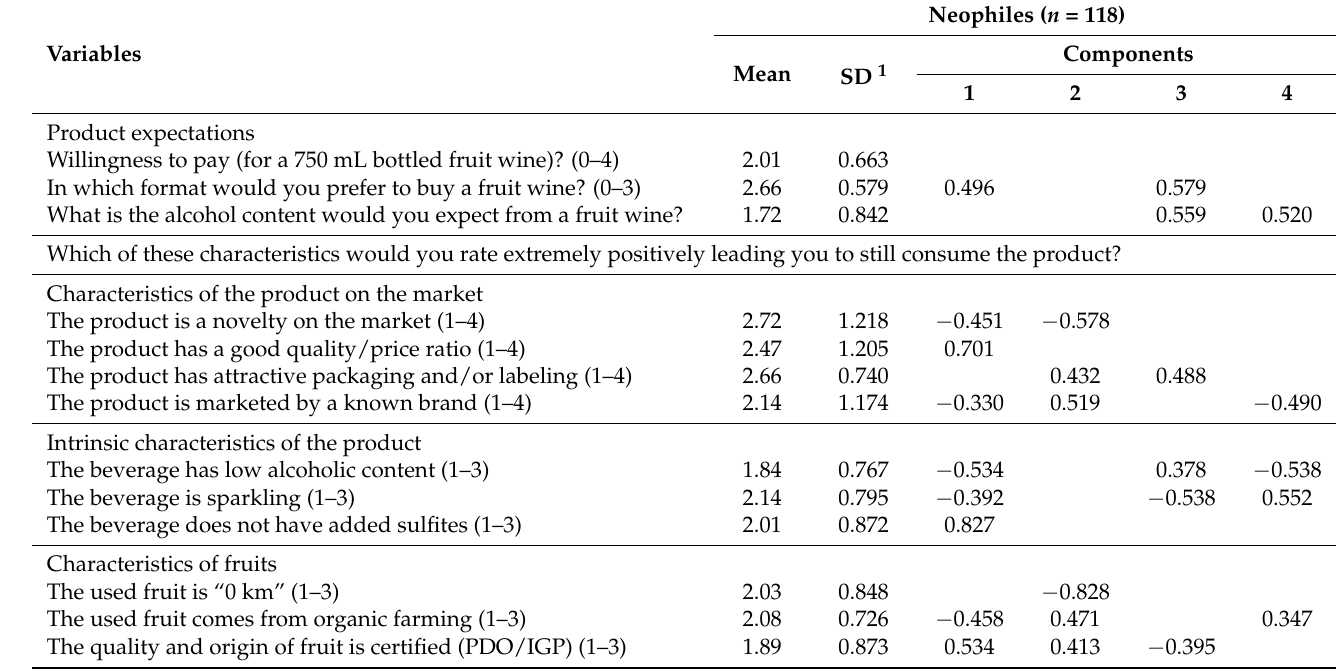
Table 5. Fruit wine expectations and perception profiles by